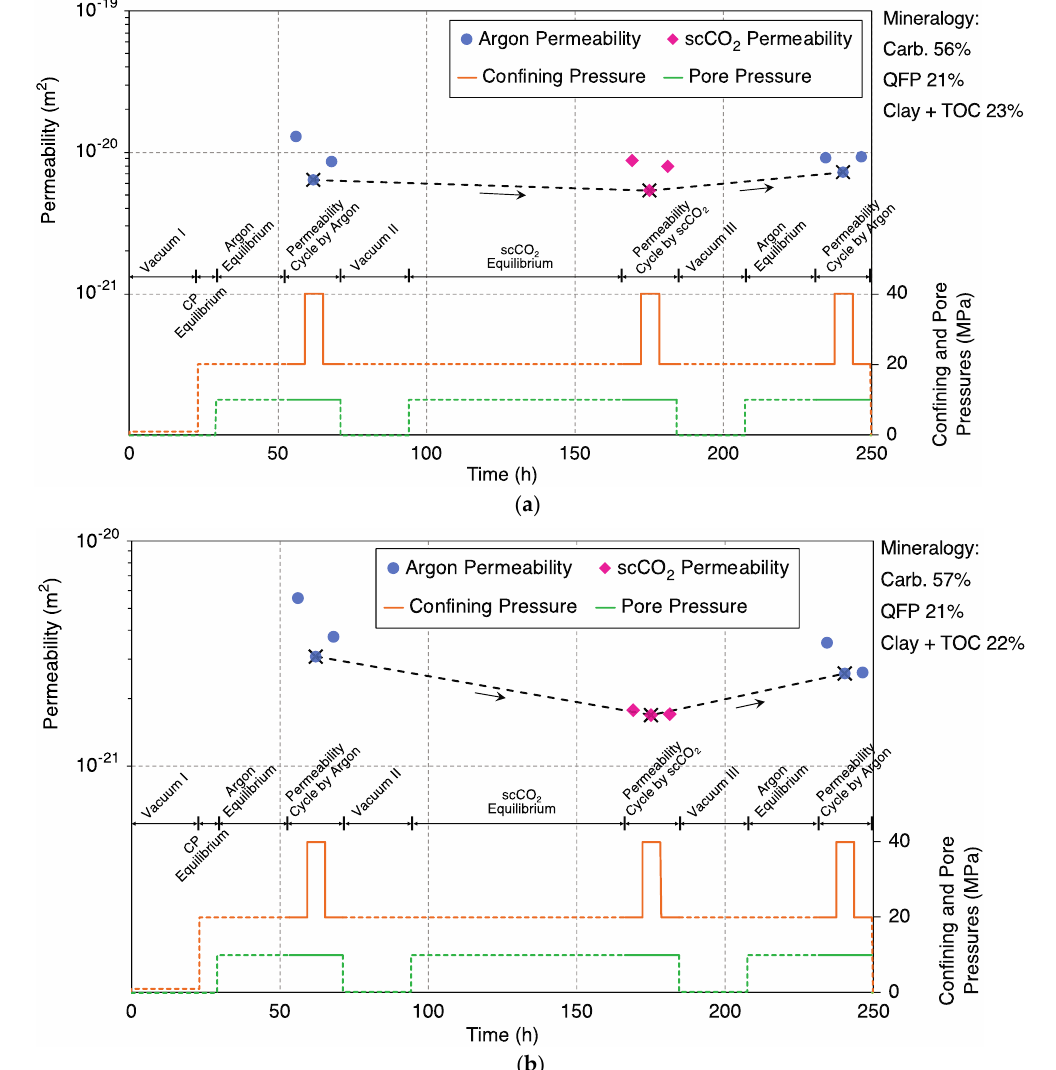
Figure 9. Permeability changes for samples ( a ) 1-63H and ( b ) 3-110H.